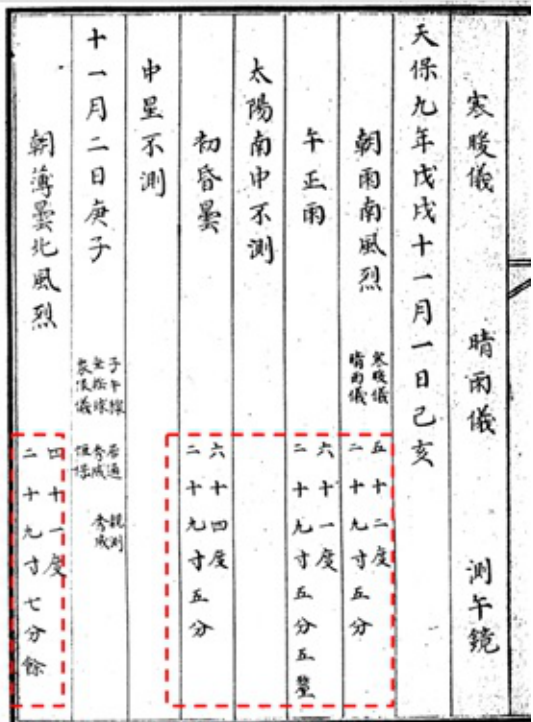
Figure 3. Record for 17 and 18 December 1838 from the calen- dar series (Reiken-koubo) stored in the National Archives of Japan. This is the first page of the temperature and pressure observations, which are shown in the area surrounded by red dashed